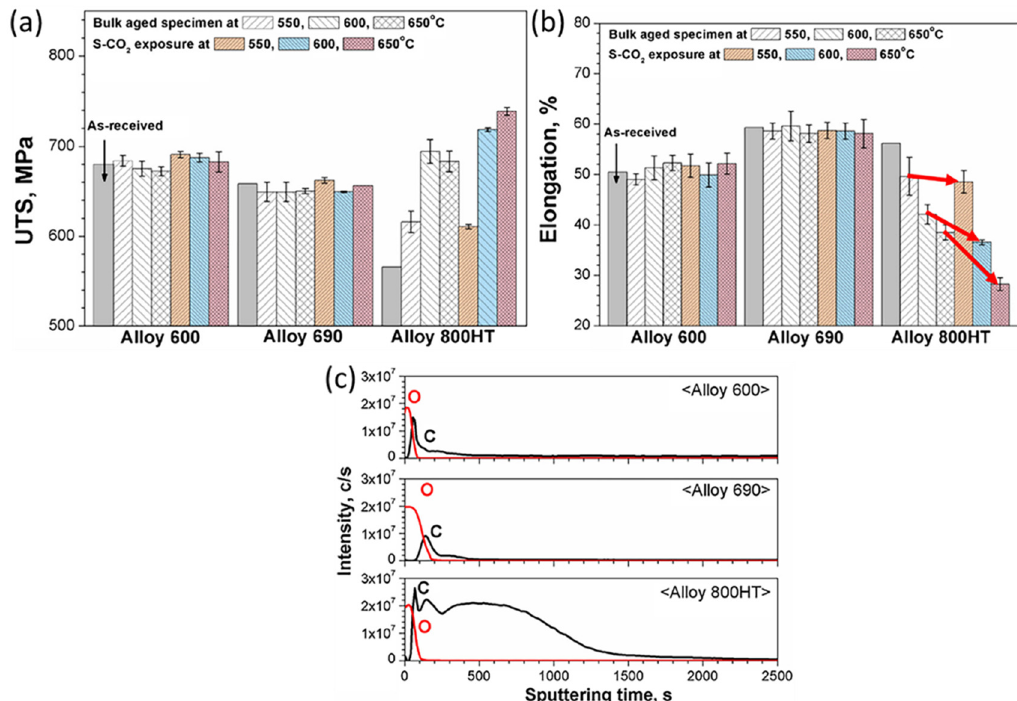
Figure 24. Results of room temperature mechanical properties for S-CO 2 (20 MPa) exposed and bulk-aged samples at 550 °C, 600 °C and 650 °C for 1000 h compared to as-received conditions; ( a ) ultimate tensile strength and ( b ) elongation (arrows indicate the effect of exposure to S-CO 2 ). ( c ) Results of SIMS depth profile of C and O for alloy 600, alloy 690 and alloy 800HT corroded at 600 °C for 1000 h [29]. Reproduced with permission from Elsevier.